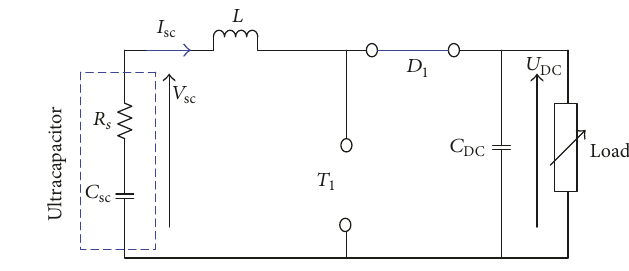
Figure 8: Equivalent circuit for Case 1. Figure 9: Equivalent circuit for Case